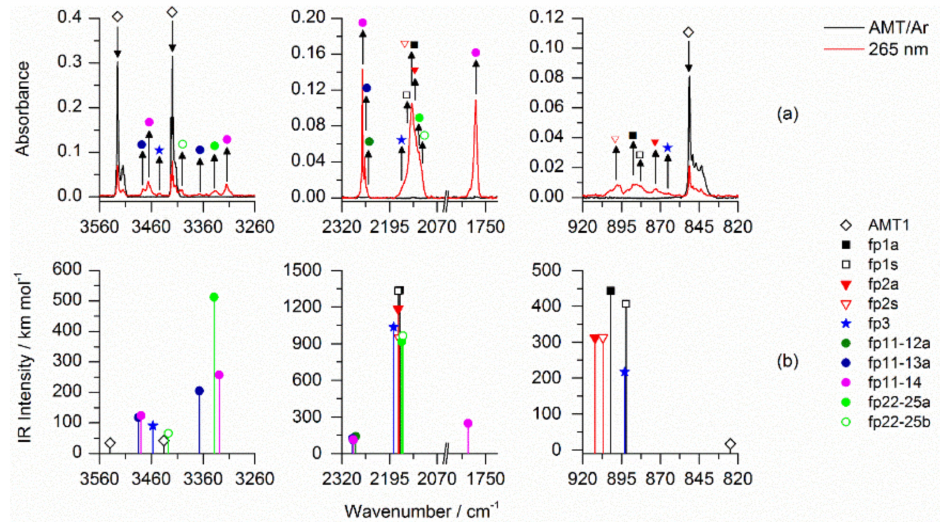
Figure 3. Selected regions of the AMT/Ar spectra: ( a ) after deposition at 15 K/10 K (black traces) and after 300 min irradiation at 265 nm (red traces), ( b ) B3LYP/6-311++G(3df,3pd) stick spectra of the identified photoproducts. Table 3. Experimental and B3LYP/6-311++G(3df,3pd) calculated wavenumbers (cm − 1 ) and